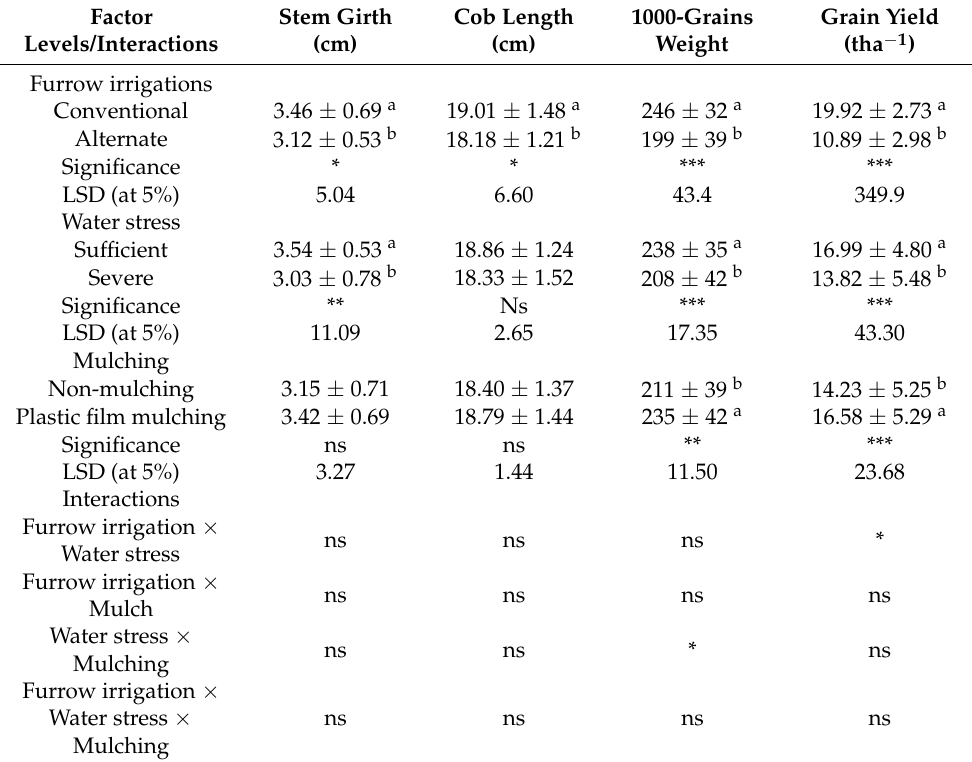
Table 5. Factor effects and interactions of furrow irrigation method, water stress, and plastic mulching on mean stem girth, cob length, 1000 grains weight, and grains